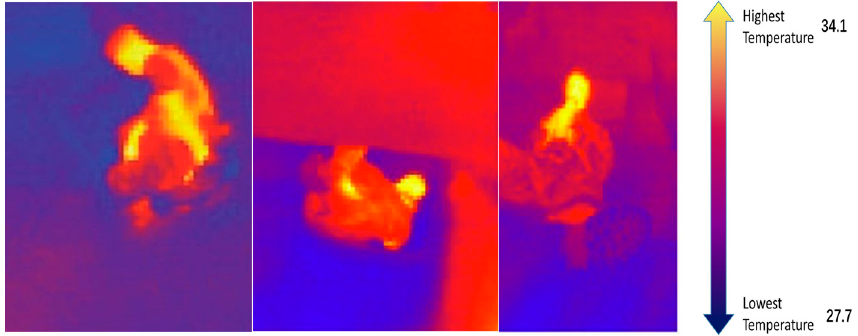
Figure 1. Three images from thermal camera from different directions.